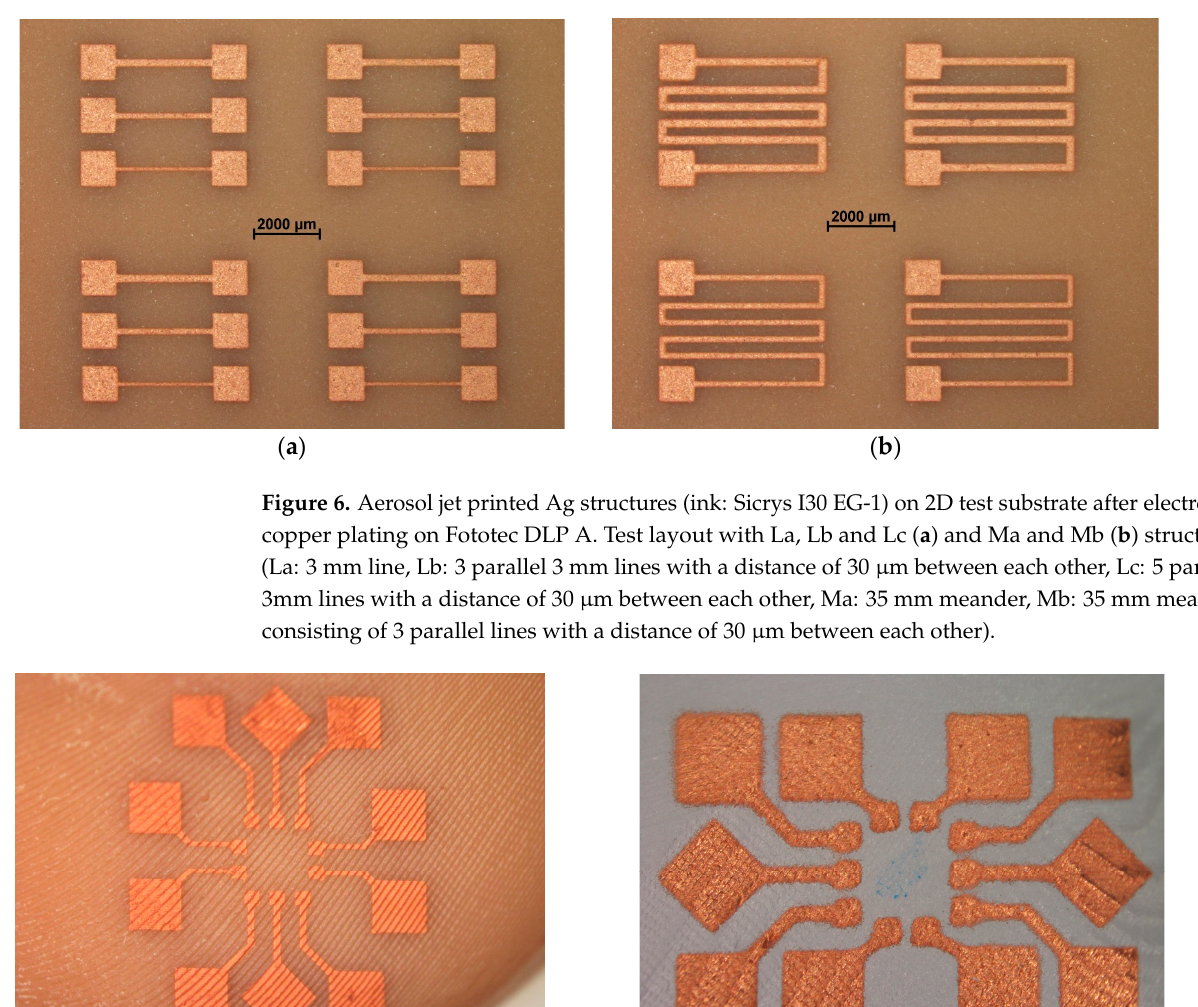
Figure 5. Electroless copper plating on printed silver tracks (ink: Sicrys I30 EG-1) on 2D test substrates with 60min plating time on Dreve FotoTec DLP-A ( a ) and on Luxaprint 3D mold ( b ) and with 15min plating time on Dreve FotoTec DLP-A ( c ) and on Luxaprint 3D mold ( d ).